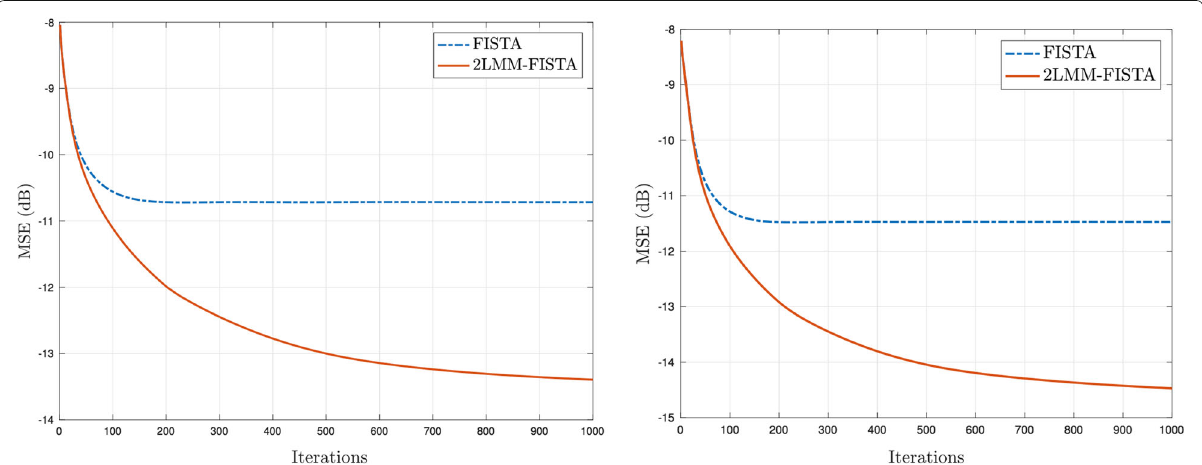
Fig. 15 Analysis of rate of convergence in image deblurring: Lena (left) and cameraman (right): MSE (dB) versus number of iterations